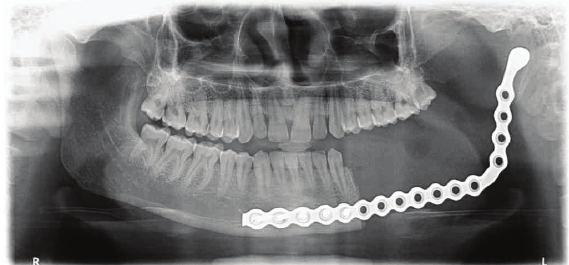
Figure 8: Posttreatment OPG after